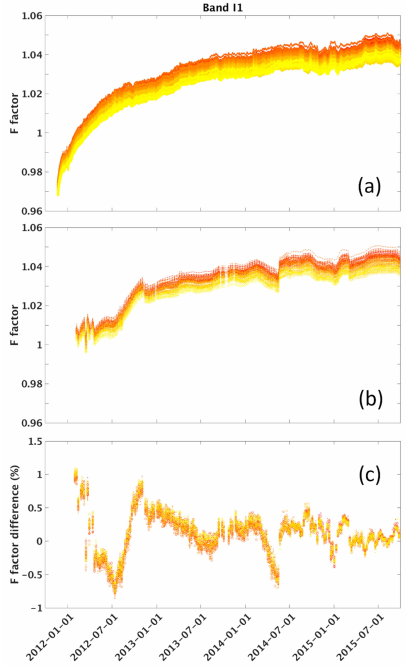
Figure A9. ( a ) VIIRS band I1 (640 nm, single gain) radiometric calibration scaling coefficients (the F factors) derived by the automated calibration procedure; ( b ) the F factors used in the operational production of the VIIRS SDR; and ( c ) relative difference between the operational F factors and the reprocessed ones (used here as a baseline). Symbol legend is the same as in Figure 4.